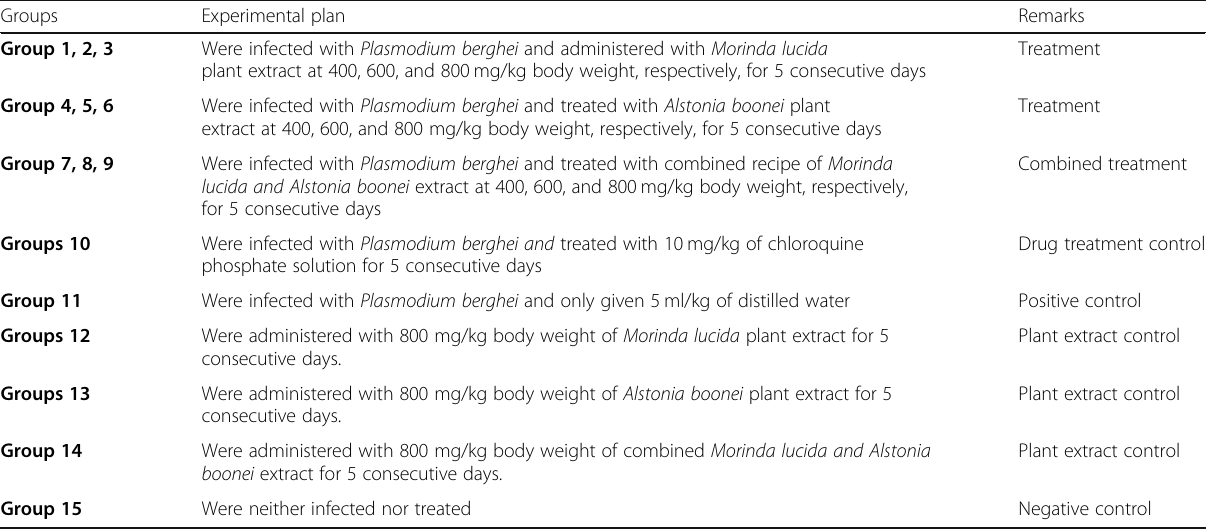
Table 2 Experimental plan for test animals and control